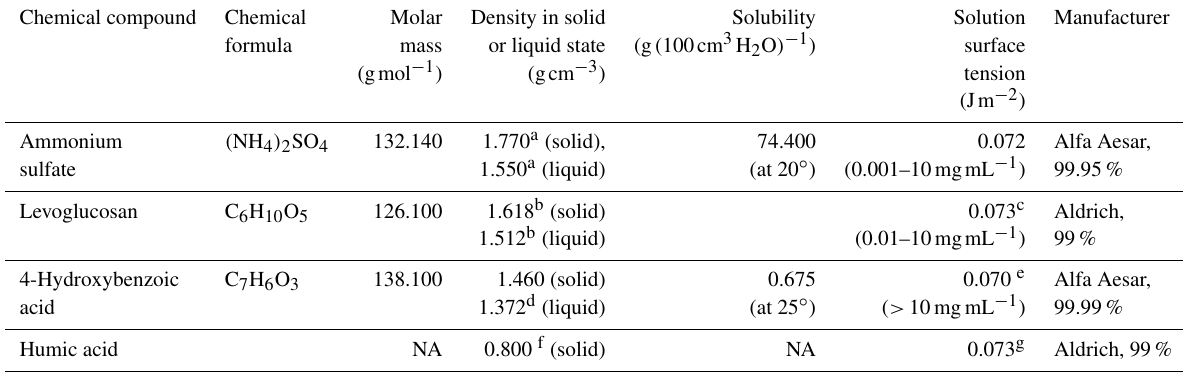
Table 1. Substances and their physical properties used in this work. Chemical compound Chemical